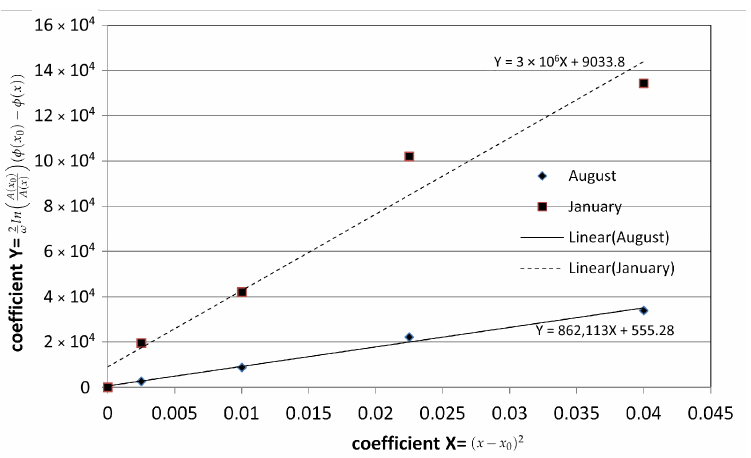
Figure 8. Linear regressions of the measured data for the Ångström